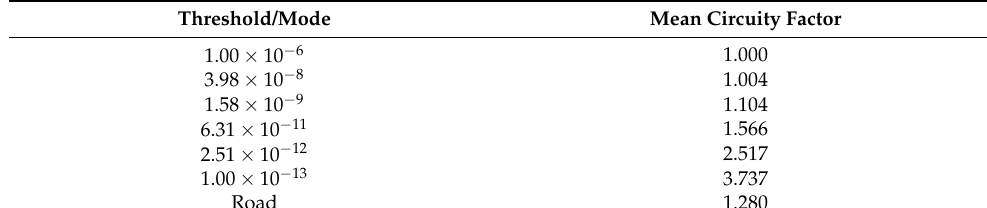
Table 5. Mean Circuity Results for Each Threshold/Mode.